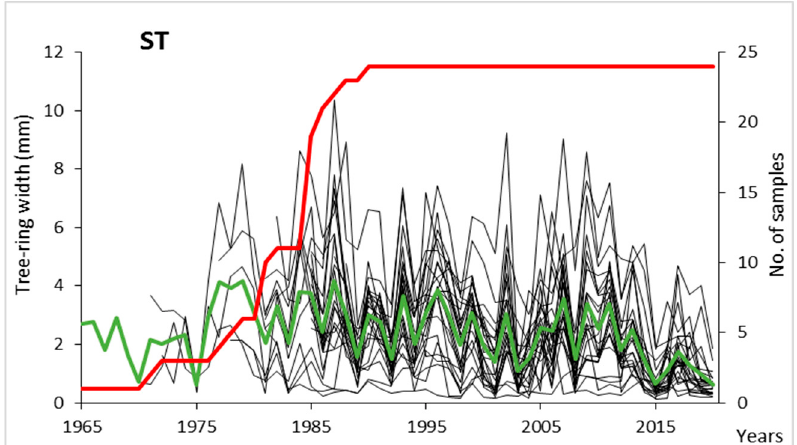
Figure 2. Individual sequences of tree-ring width (thin black lines), making up the local hawthorn chronology (ST; green line), and number of samples included in the chronology (red line).